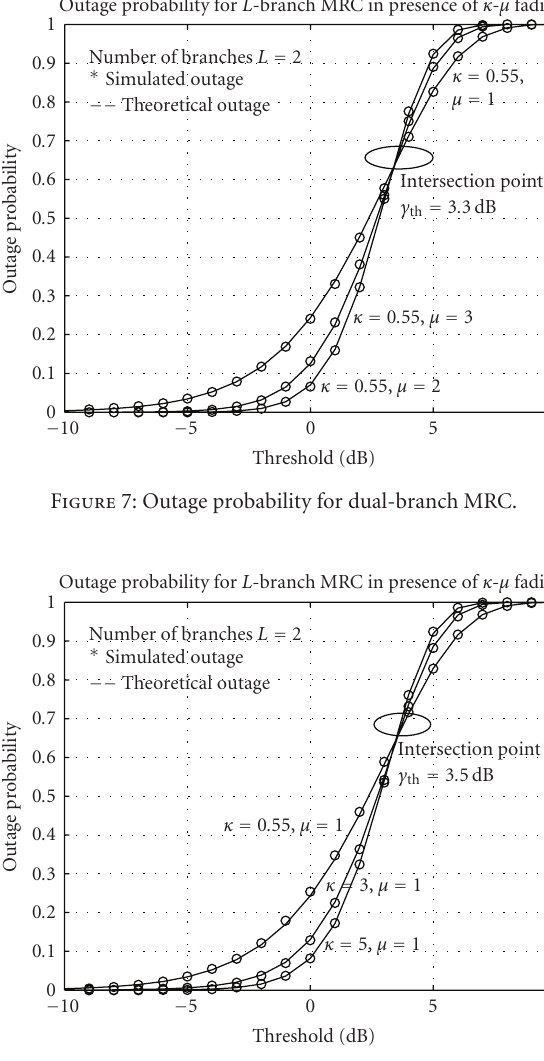
Figure 8: Outage probability for dual-branch